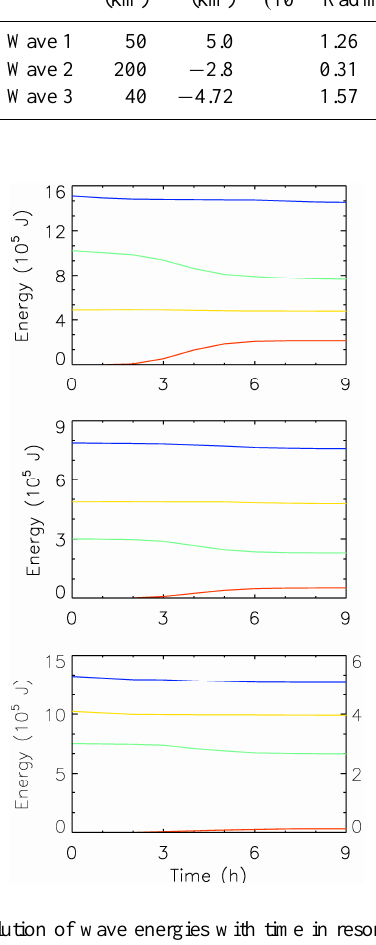
Fig. 3. Evolution of wave energies with time in resonant interac- Figure 3. Evolution of wave energies with time in resonant interactions in cases 1-3. The green, yellow tions in cases 1–3. The green, yellow and red lines denote energies and red lines denote energies of the primary, secondary and excited waves, respectively; and the blue line of the primary, secondary and excited waves, respectively; and the blue line denotes their total energy. The top, middle and bottom denotes their total energy. The top, middle and bottom panels represent the results in cases 1-3, respectively. panels represent the results in cases 1–3, respectively. Note in bot- tom panel, the scales for the energies of the primary (green) and Note in bottom panel, the scales for the energies of the primary (green) and excited (red) waves are on the excited (red) waves are on the right due to their small right due to their small values.